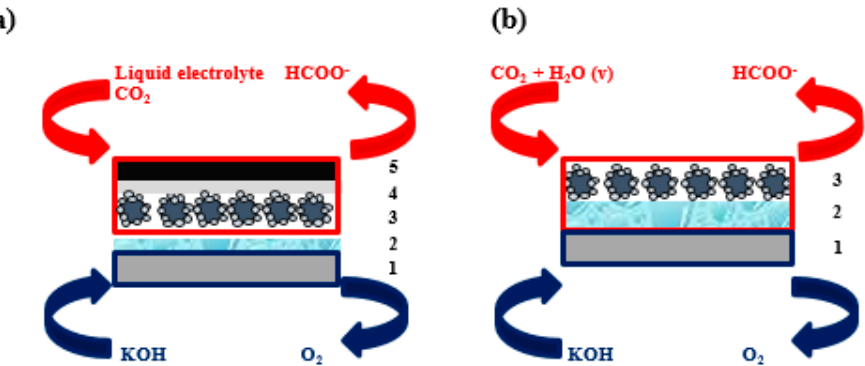
Figure 5. Scheme of ( a ) Gas Di ff usion Electrode (GDE) configuration and ( b ) Catalyst Coated Membrane Electrode (CCME) configuration (1: the counter electrode; 2: the cationic exchange membrane; 3: the catalytic layer; 4: the microporous layer, and 5: the carbon support). Please note that there are no elements 4 and 5 in ( b ) because in the CCME configuration, the catalyst is deposited directly on the membrane, avoiding the use of a carbon support and microporous layer. Table 4. Value of thickness of the di ff erent layers shown in Figure 5 in each of the electrodes employed in the references [66–69]. Sn / C GDEs